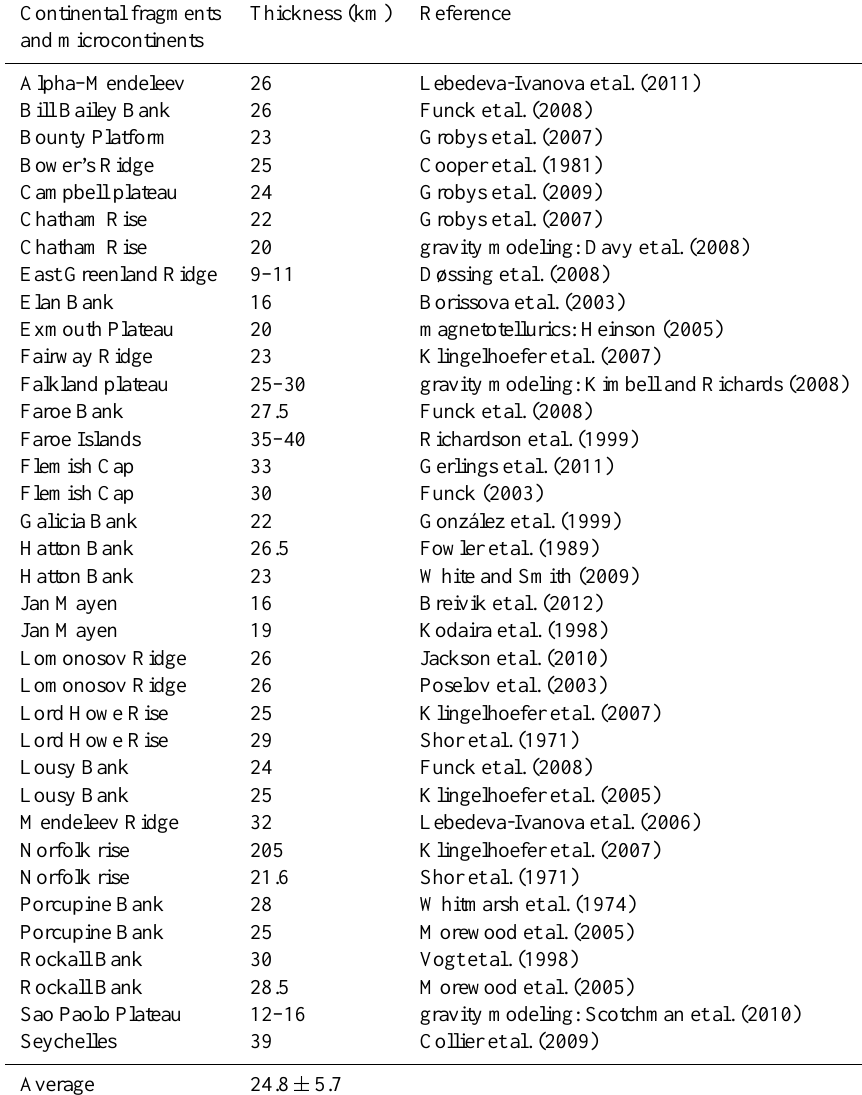
Table 5. Crustal thicknesses of continental fragments from seismic studies unless otherwise